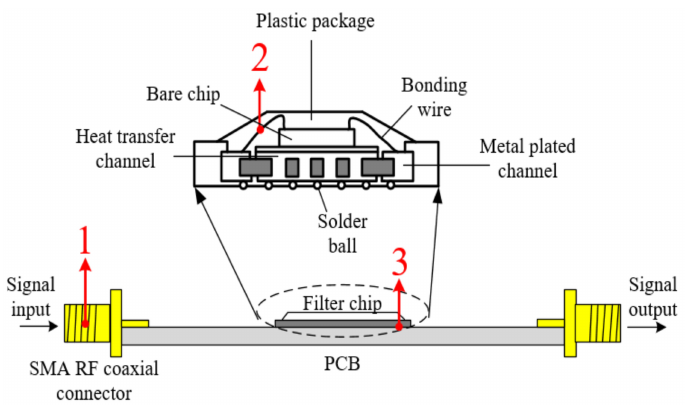
Figure 8. Schematic structure of a filter circuit, where position 1, 2 and 3 represent a connector connection, a bonding wire connection, and a solder ball connection,